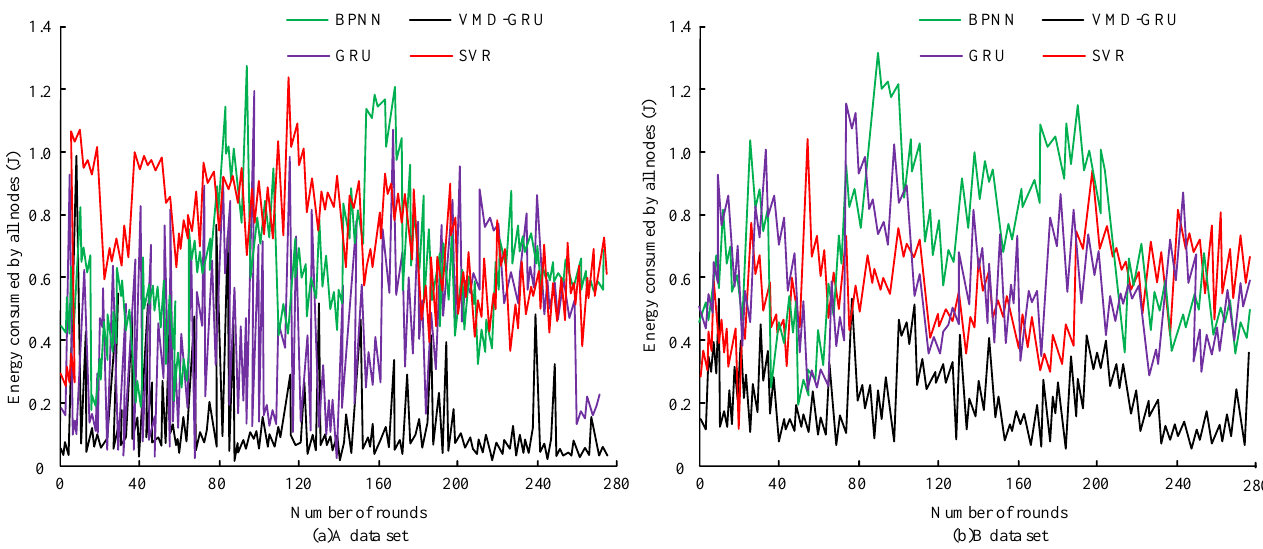
Figure 7. Comparison of network energy consumption under different algorithm models in A and B datasets.